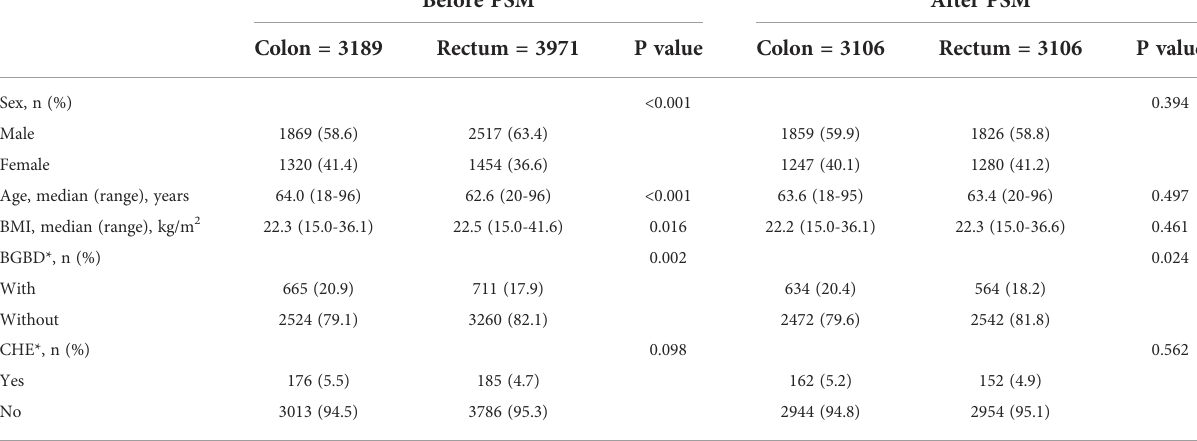
TABLE 3 Analysis between colon cancer and rectal cancer before and after PSM.